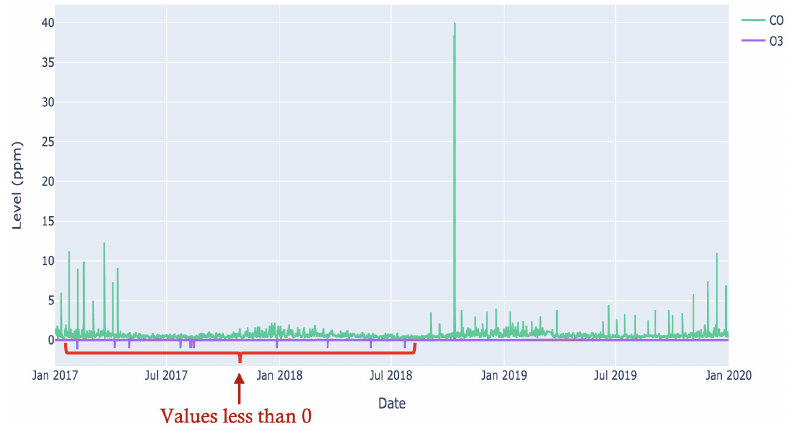
Figure 3. Anomalies in the CO and O 3